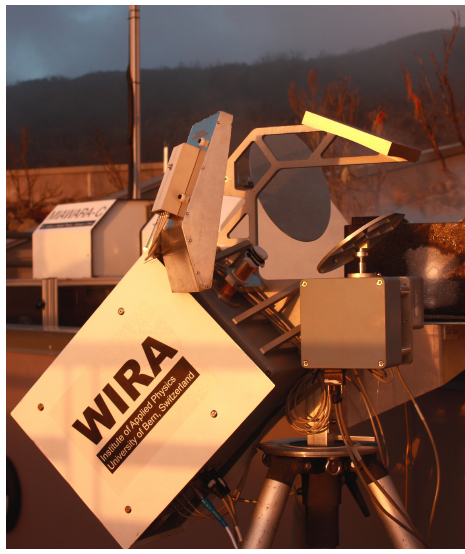
Figure 1. WIRA’s frontend during its operation at the Observatoire du Maïdo on La Réunion